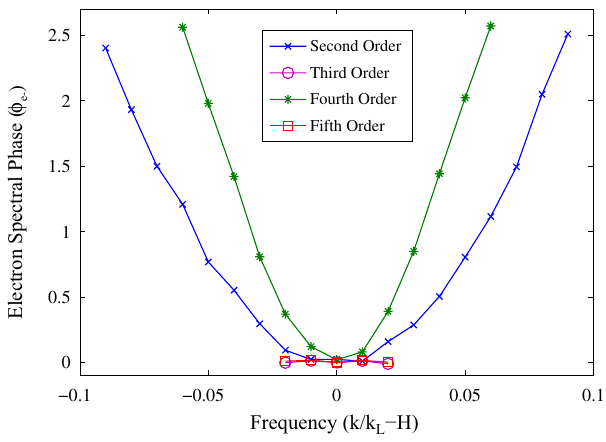
FIG. 7. Electron spectral phase, (cid:3) seed laser pulses with 2nd through 5th order spectral phase. For each curve the spectral phase of the laser seed has (cid:3) ð (cid:5) k Þ ¼ (cid:3) (cid:5) kn =n ! ¼ 1 [Eq. (4)]. The bandwidth (cid:1) k n plotted range; the odd order cases produce narrower bandwidths.